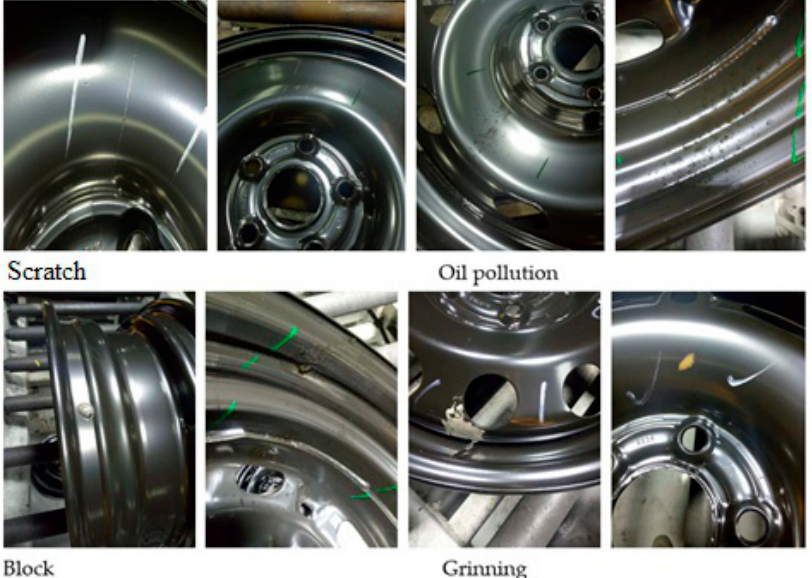
Figure 2. Types of wheel hub defects.